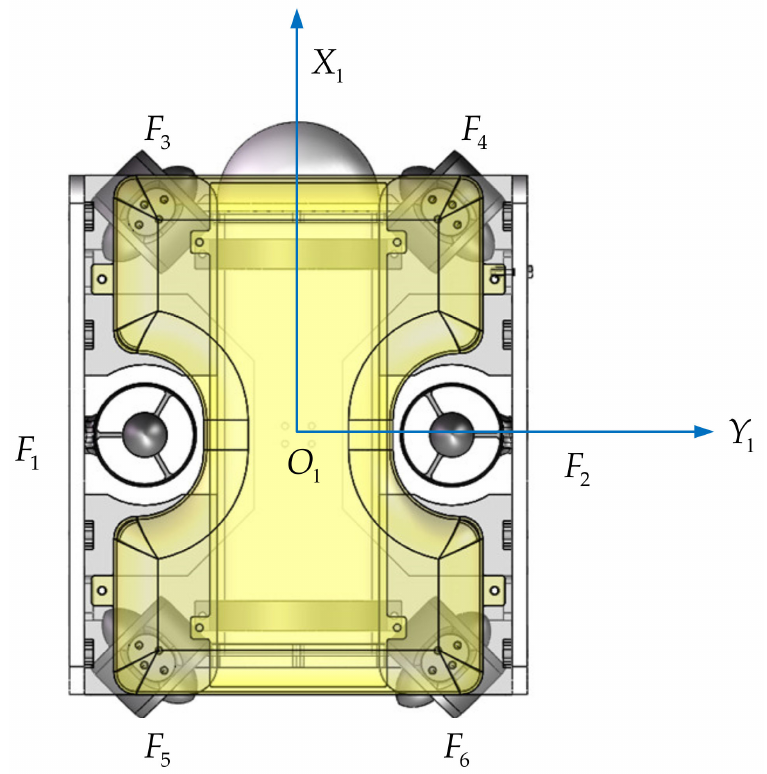
Figure 3. Planform of the designed